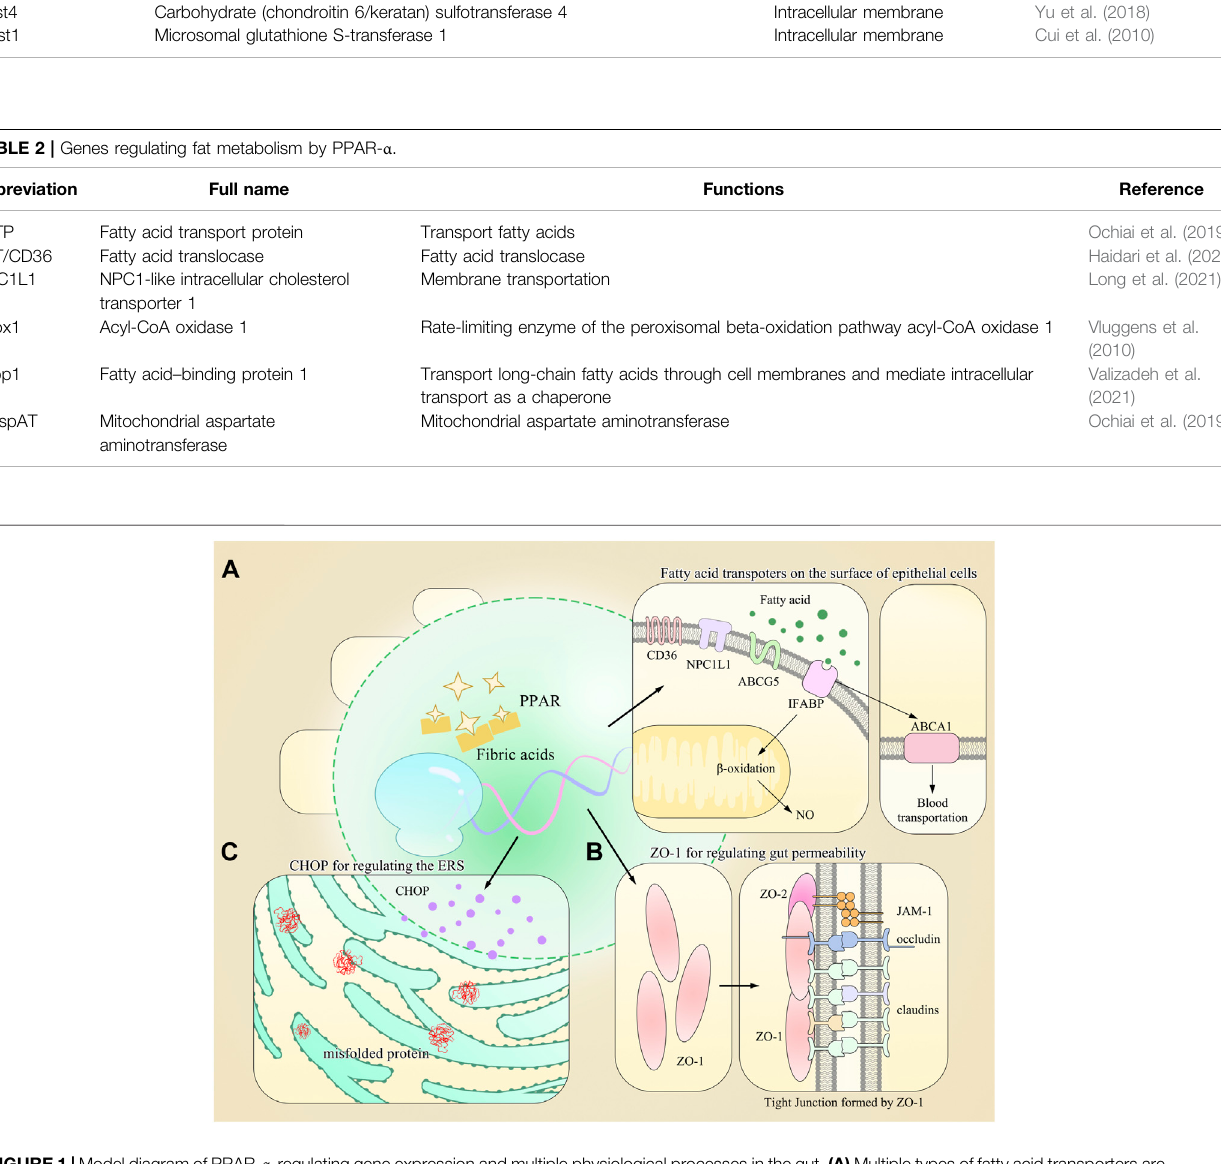
FIGURE 1 | Model diagram of PPAR- α -regulating gene expression and multiple physiological processes in the gut. (A) Multiple types of fatty acid transporters are found on the surface of gastrointestinal epithelial cells, and most of their synthesis requires the activation of PPAR- α . (B) Other proteins maintaining the homeostasis of GIT are also regulated by PPAR- α , such as ZO-1 for gut permeability. (C) PPAR- α also regulates the expression of CHOP, which is responsible for regulating the endoplasmic reticulum stress